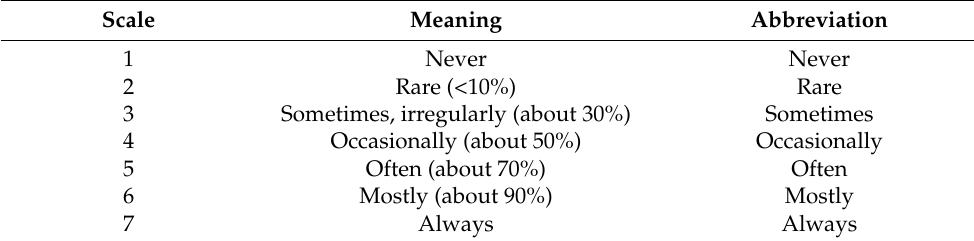
Table 2. Scale of response.